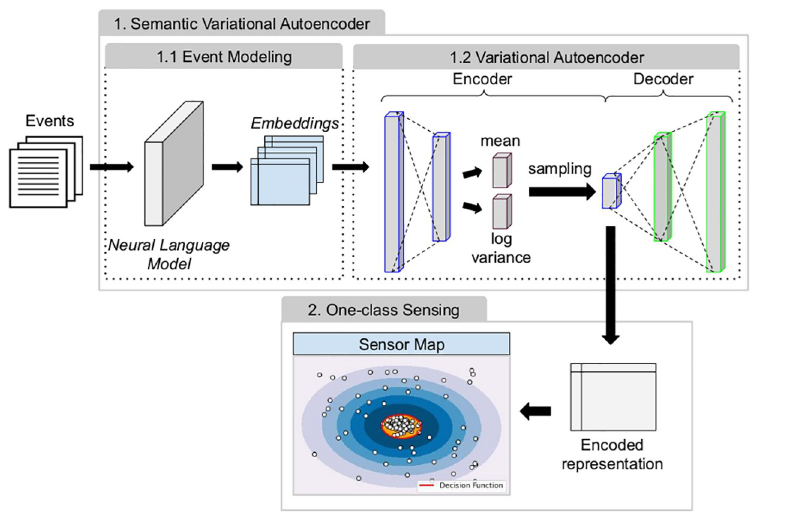
Fig 2. An overview of the proposed learning to sense